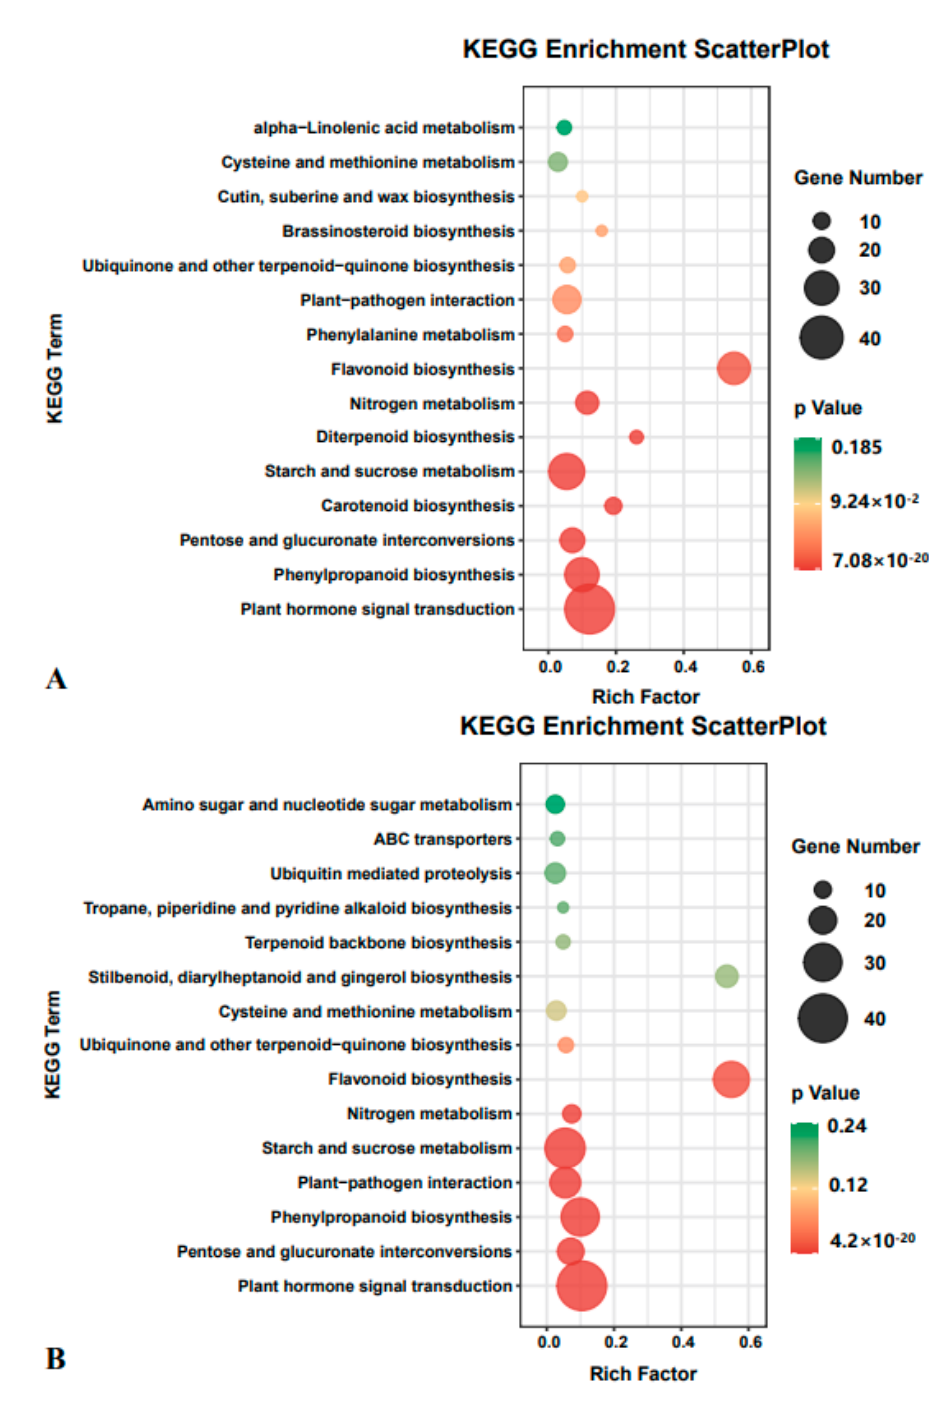
Figure 3. Candidate differentially expressed gene Kyoto Encyclopedia of Genes and Genomes (KEGG) enrichment factor map, sorting the top 15 pathways according to the p -value. ( A ) Upregulated expression trend in differential gene enrichment results; ( B ) downregulated expression trend in differential gene enrichment results.